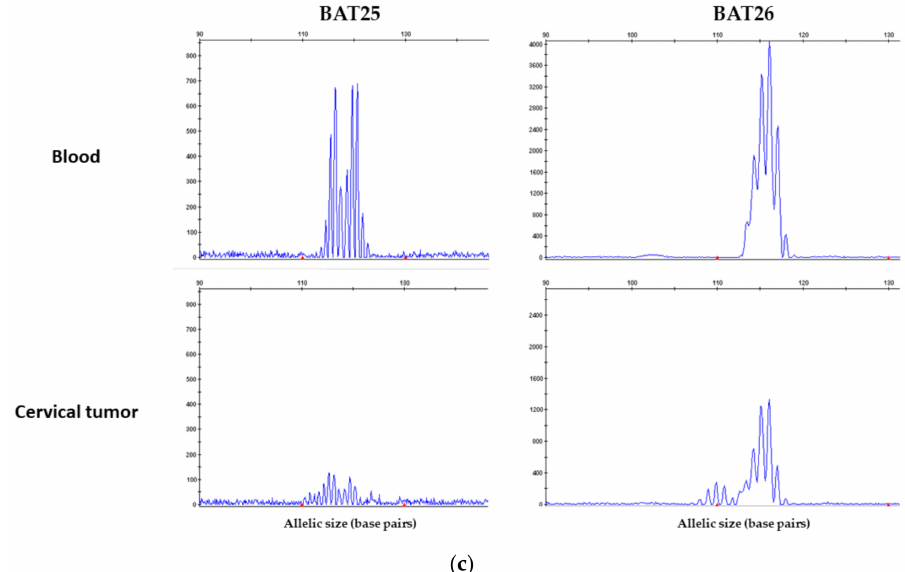
Figure 3. ( a ) Immunohistochemical staining of the colon carcinoma. The colon carcinoma was negative for MSH2 (MutS Homolog 2) and MSH6 (MutS Homolog 6) and positive for MLH1 (MutL Homolog 1) and PMS2 (PMS1 Homolog 2) (200 × ), which was in agreement with the germline mutation in MSH2 and MSH6 ; ( b ) Immunohistochemical staining of the cervical carcinoma. The cervical carcinoma was negative for MSH2 and MSH6 and positive for MLH1 and PMS2 (200 × ), which was in agreement with the germline mutation in MSH2 and MSH6 ; ( c ) Microsatellite instability analysis of the cervical carcinoma. Allele length patterns of eight mononucleotide markers in control ( top ) and cervical tumor ( bottom ) tissues; two microsatellite markers (BAT25 and BAT26) show instability, visible as the shift in the size (base pairs) of the amplification products in the cervical tumor sample (BAT25) and new alleles in the cervical tumor sample